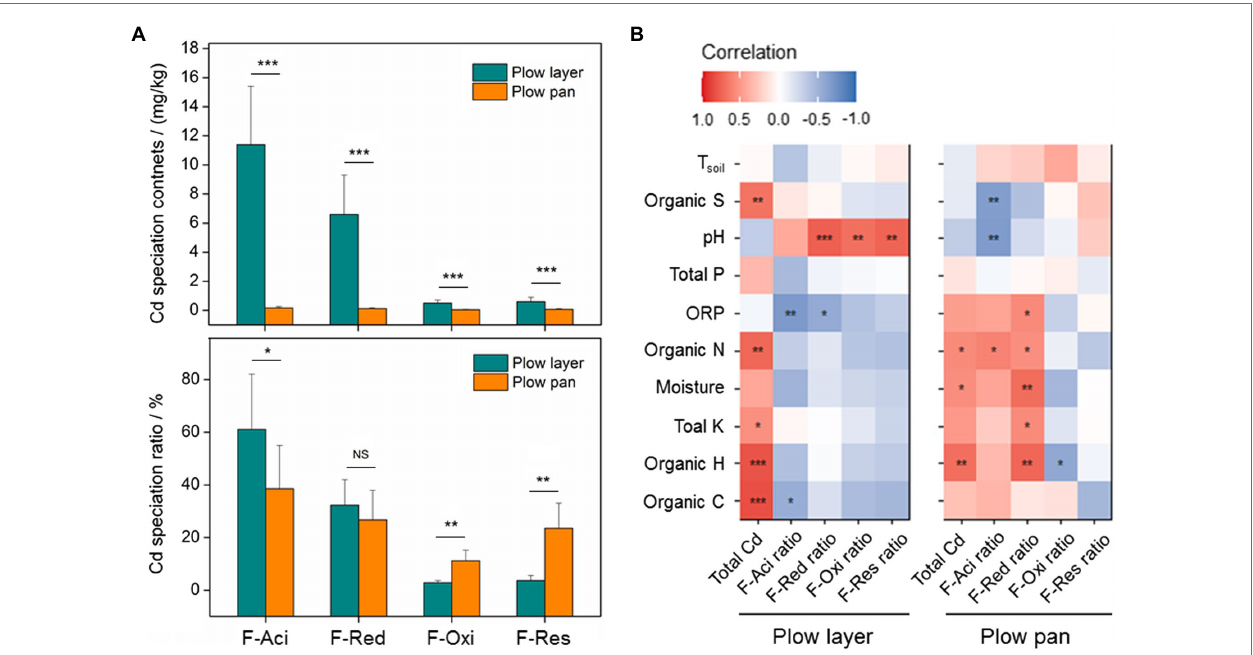
FIGURE 1 | Cd speciation distribution and relationships between the soil variables and Cd speciation ratios in the plow layer and plow pan soils. (A) Distributions of Cd speciation contents and ratios between the two soil layers. (B) Pearson correlation analysis. F-Aci, F-Red, F-Oxi, and F-Res indicate the acid-soluble fraction, reducible fraction, oxidizable fraction, and residual fraction of Cd, respectively. Asterisks indicate the significant difference or correlation (* p < 0.05, ** p < 0.01, and *** p < 0.001).